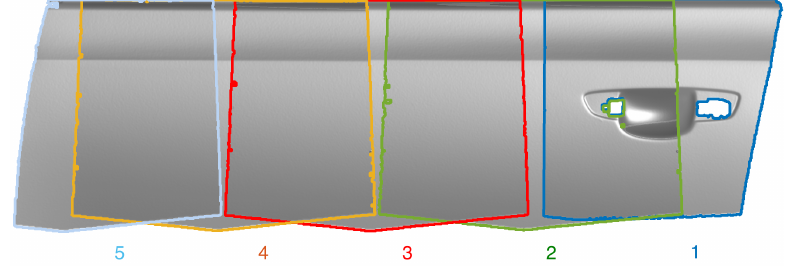
Figure 1. Visualisation of 5 partially overlapping measurements for a surface measurement of an unpainted sheet metal car door panel.